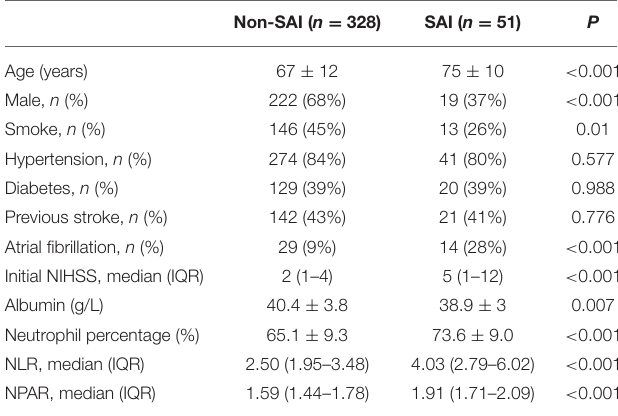
TABLE 1 | Baseline characteristics of AIS patients with SAI and